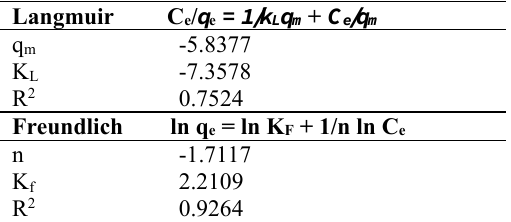
Adsorption isotherm parameters for IC adsorption on corn leaves at 30 o